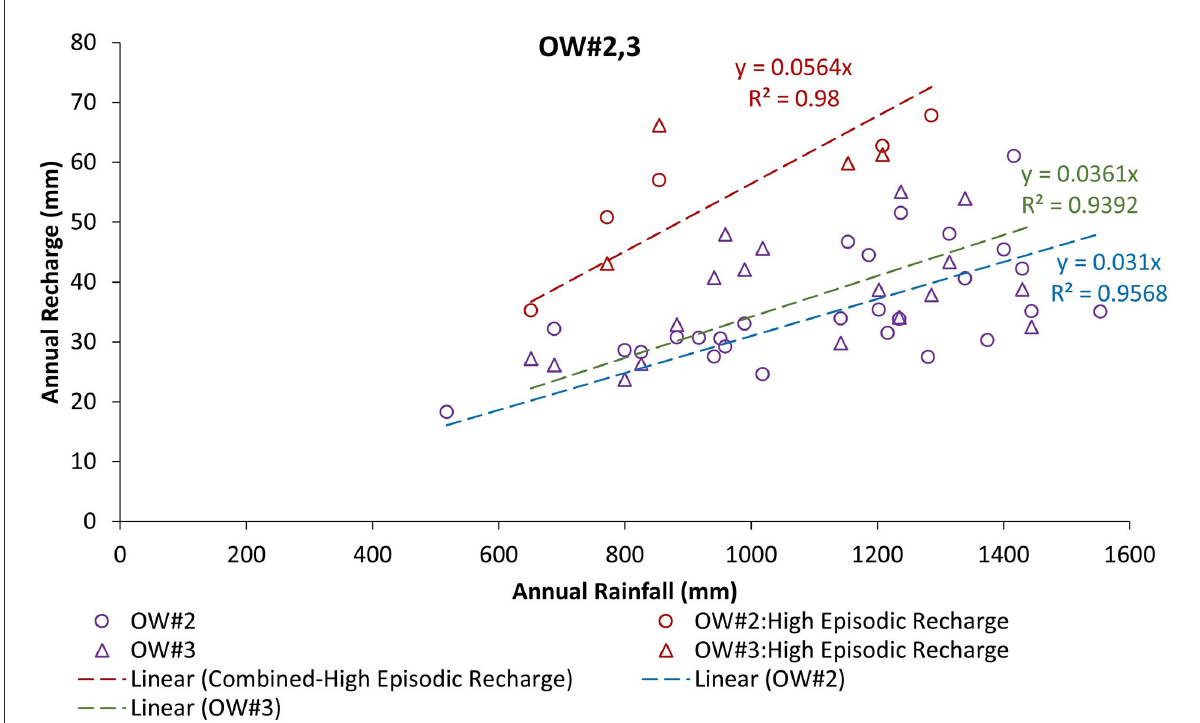
FIGURE5 Annual recharge vs. annual rainfall variation in Gundlupet taluk for OW#2 and OW#3.